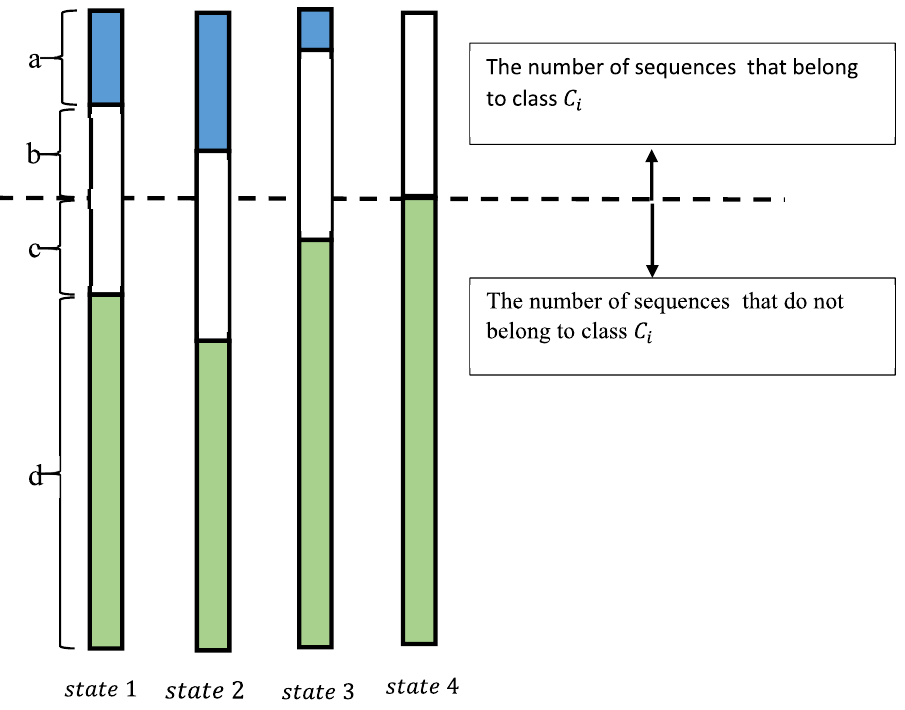
Figure 1. Distributions of feature x across classes in 4 hypothetical